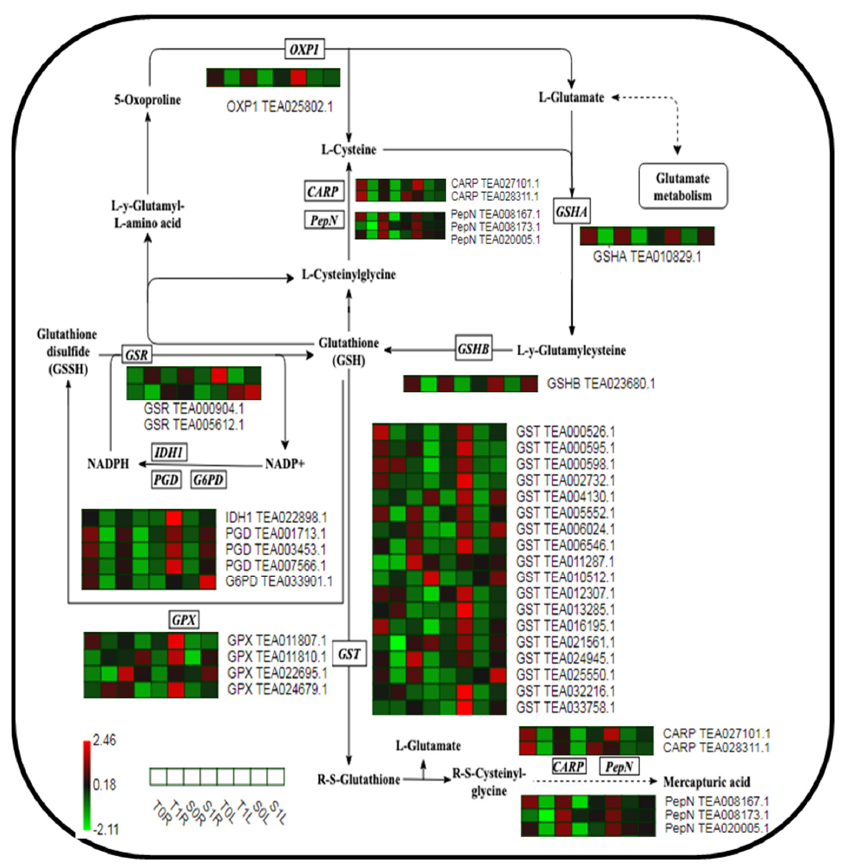
Figure 4. Differential protein expression patterns in the GSH metabolism pathway in roots and leaves of Tieguanyin and Shuixian under La treatment. T0L, Tieguanyin leaf under the control; T1L, Tieguanyin leaf treated with 1.2 mmol/L La; S0L, Shuixian leaf under the control; S1L, Shuixian leaf treated with 1.2 mmol/L La; T0R, Tieguanyin roots under the control treatment; T1R, Tieguanyin roots treated with 1.2 mmol/L La; S0R, Shuixian roots under the control; S1R, Shuixian roots treated with 1.2 mmol/L La.